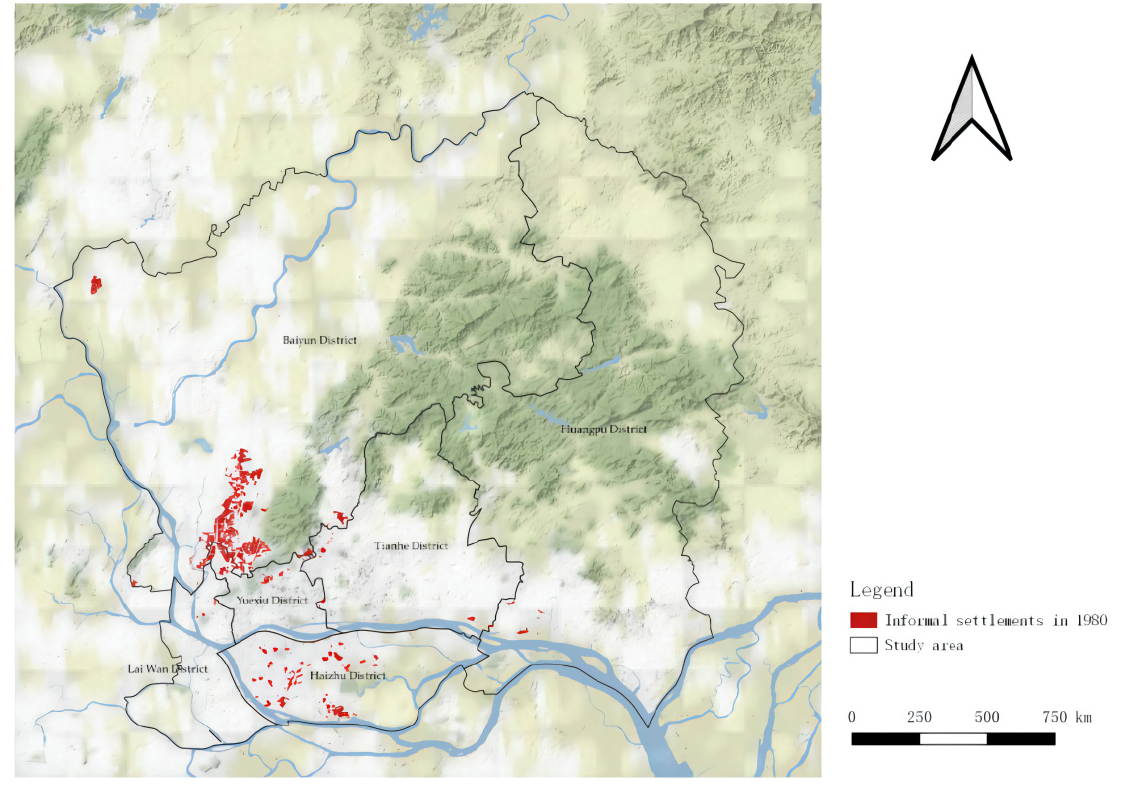
Figure 3. The spatial distribution characteristics of informal settlements in 1980. Source: drawn by the authors. The background image is from the Stamen map.